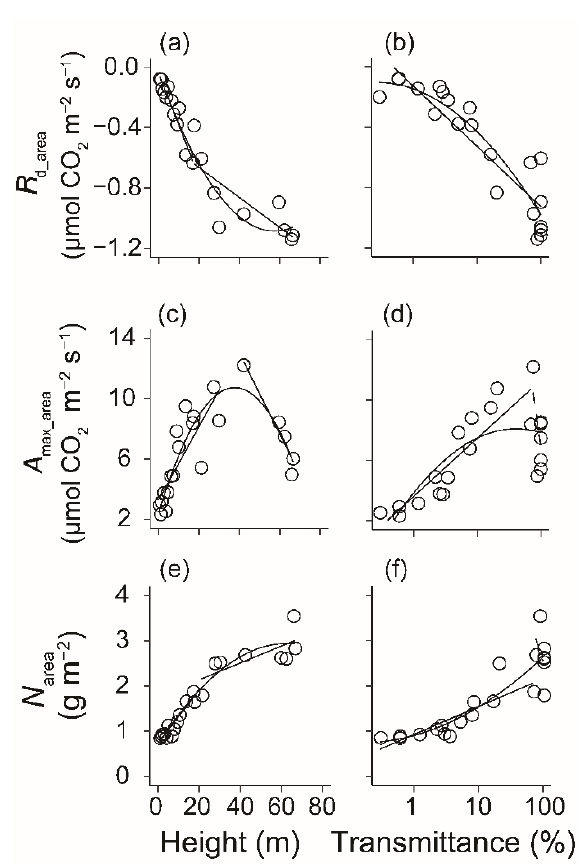
Figure 7. Area-based physiological traits such as R d_area , A max_area , and N area plotted against tree height ( a , c , e ) and light (represented as ln(%TRANS)) ( b , d , f ). Lines indicate the linear piecewise regression results; solid lines denote significant relationships ( P < 0.05), and broken lines denote nonsignificant relationships. The curve indicates the quadratic regression result. Note that a natural log scale is used on the x-axis in panels ( b , d ) and ( f ).